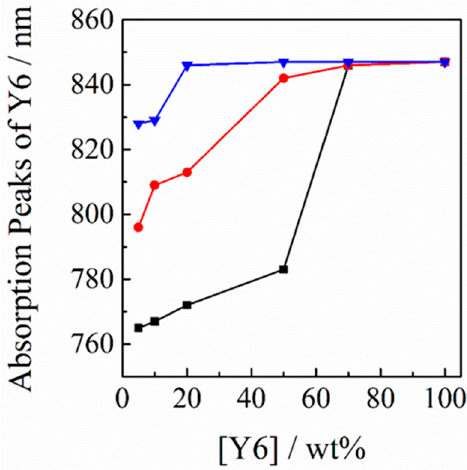
Figure 7. Peak wavelength of the Y6 absorption in different polymer matrices plotted against the weight fraction of Y6: RRa-P3HT (black line), PBDB-T (red line), and PS (blue line).